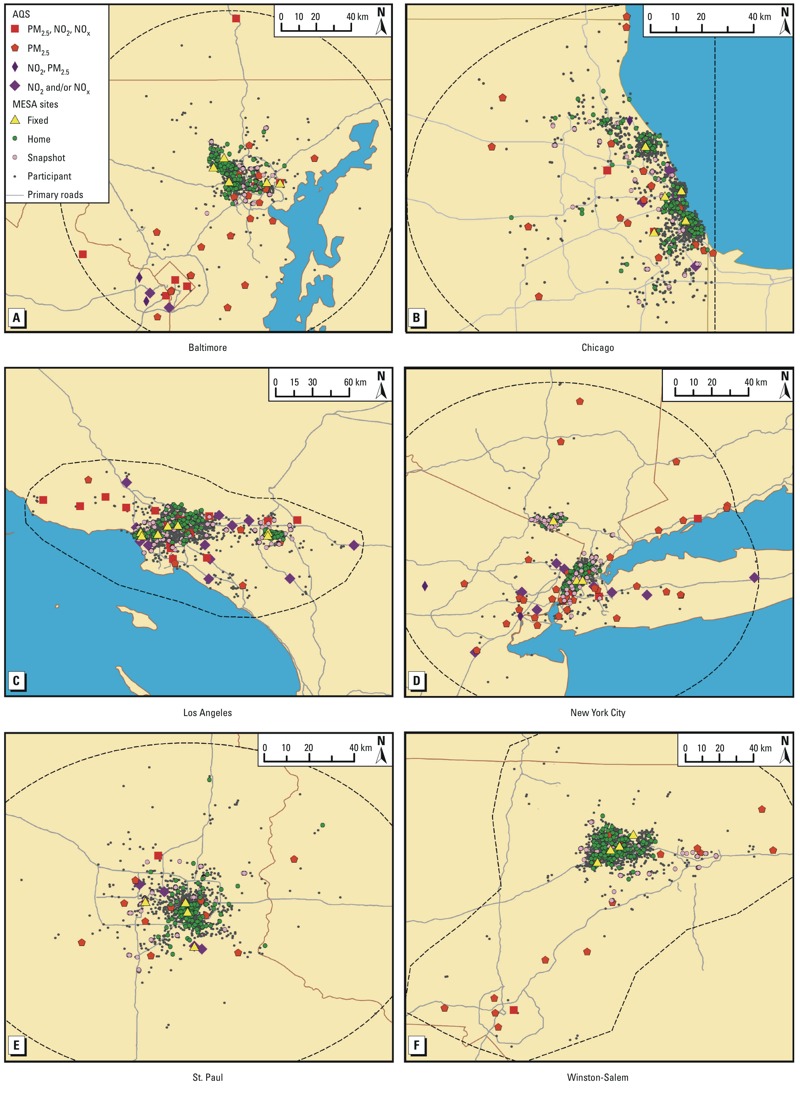
Maps of the modeling areas (denoted by dashed black line) in the six metropolitan regions, including monitor and subject locations. Abbreviations: Fixed, MESA Air fixed monitoring sites; Home, MESA Air home monitoring sites; Snapshot, MESA Air snapshot monitoring sites; Participant, MESA Air participant residence location (moved slightly to protect confidentiality).